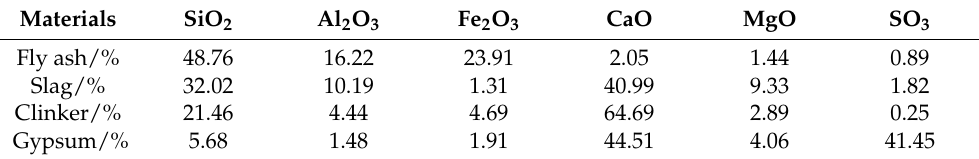
Table 3. The composition of cementitious material for each component.